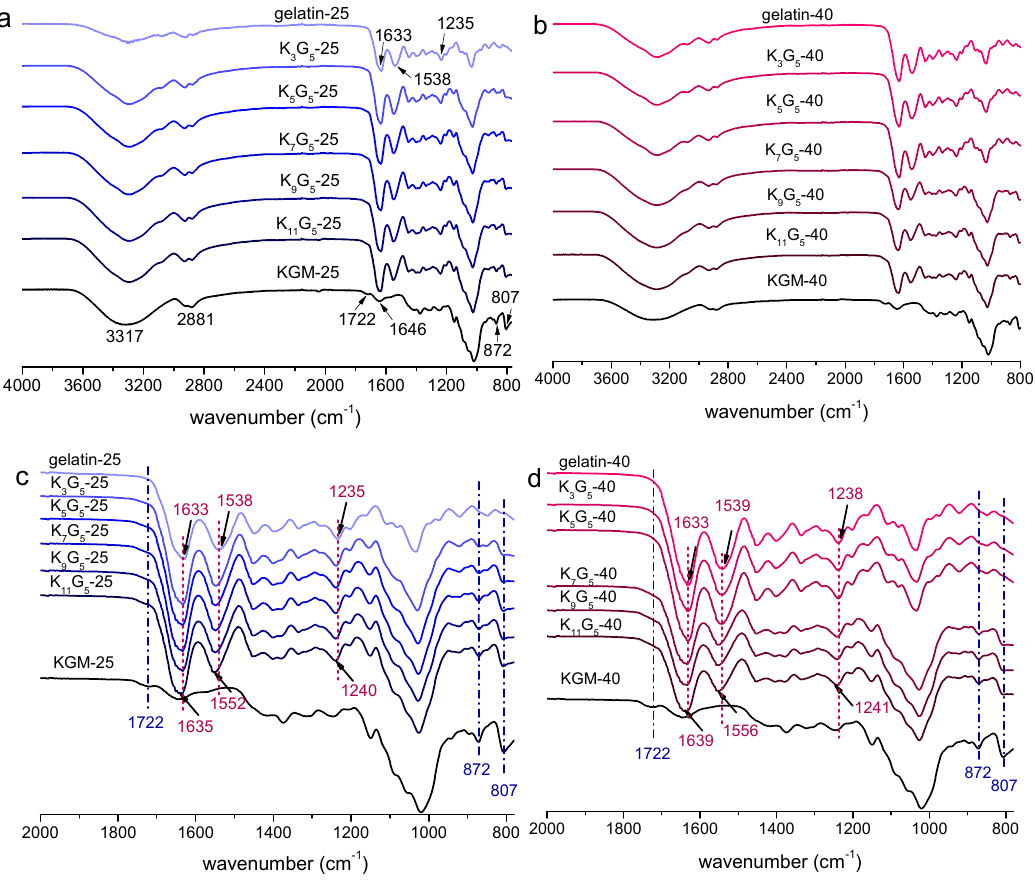
Figure 2. ATR-FTIR spectra of KGM, gelatin, and KGM / gelatin films formed under drying temperature of 25 (full ( a ); enlarged ( c )) or 40 °C (full ( b ); enlarged ( d )).